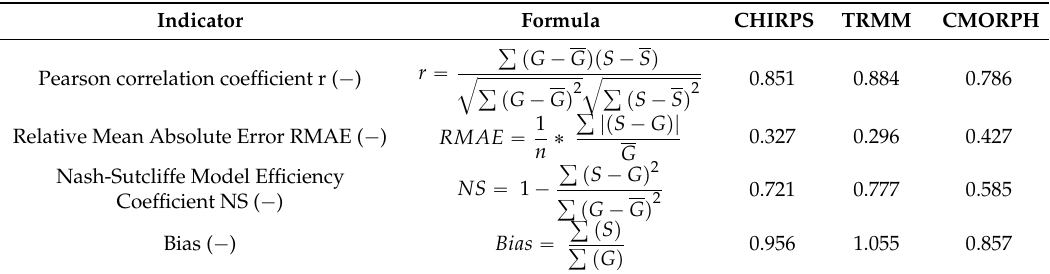
Table 2. Other pairwise validation statistics for three satellite products (S) based on all available station records (G) during the overlapping period (January 2003–December 2014). Indicator Formula CHIRPS TRMM CMORPH Pearson correlation coefficient r ( ´ ) r “ 1 Relative Mean Absolute Error RMAE ( ´ ) RMAE “ ˚ n